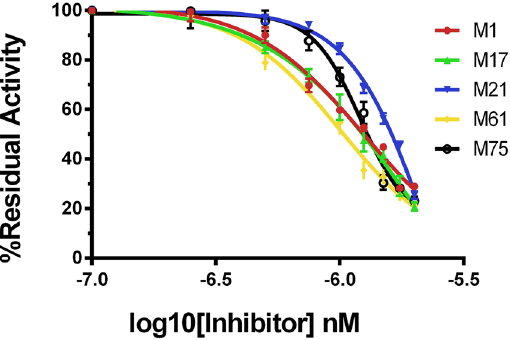
Figure 3. Representation of IC50 values for various type of inhibitors with residual activity of NDM-1as monitored by the hydrolysis of different concentration of inhibitor with constant value of 100 μ M nitrocefin.